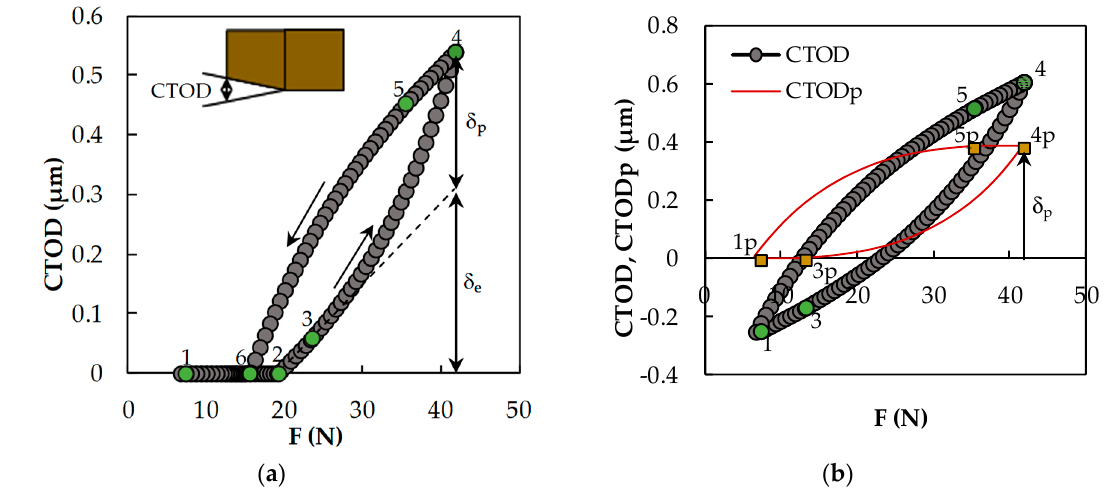
Figure 2. ( a ) Crack tip opening displacement (CTOD) vs. load (with crack closure); ( b ) CTOD and plastic CTOD vs. load (without crack closure); (SS304L mixed hardening).